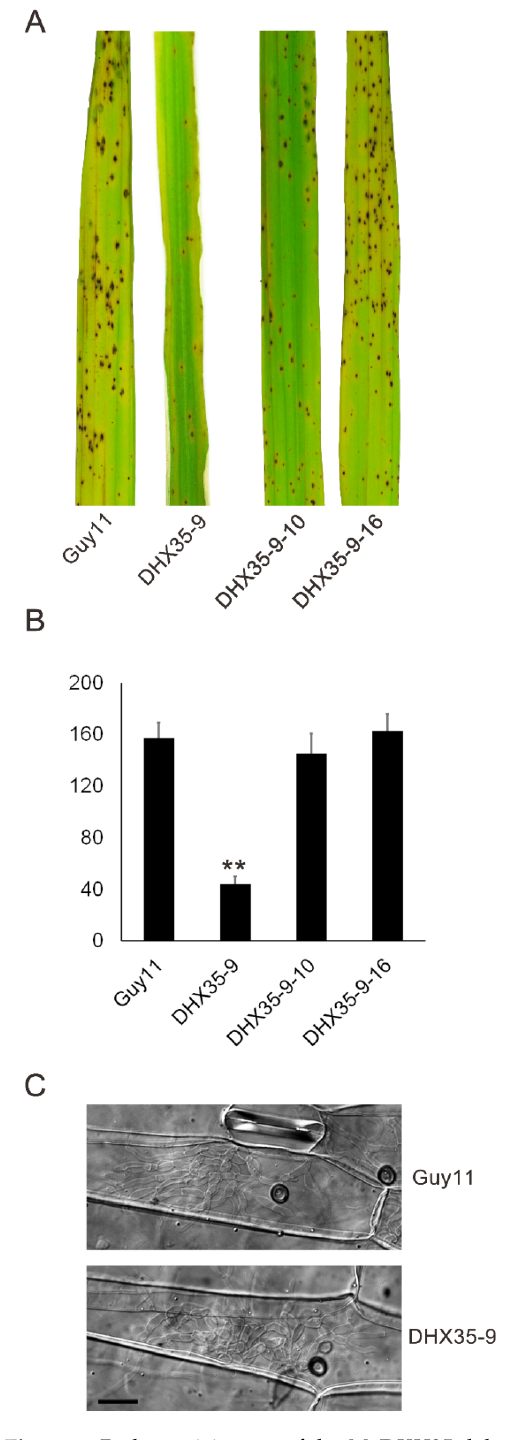
Figure 7. Pathogenicity test of the MoDXH35 -deleted mutants. ( A ) Spray inoculation with conidial suspension (1 × 10 5 conidia/mL) on 2-week-old rice cultivar CO39, recorded at 7 days post inocula- tion (dpi). ( B ) The numbers of lesions on 5-cm leaves were counted and statistically analyzed. Error bars represent the deviation from three replicates and double asterisks indicate significant differences at p < 0.01 level. ( C ) The infection structures of the mutant and the wild type were compared on barley leaves. The detached barley leaves were drop inoculated with the conidia suspension and incubated for 36 hpi. The infection hyphae of the mutant were found to develop at an equivalent level as that of the wild type. The bar =10 µ